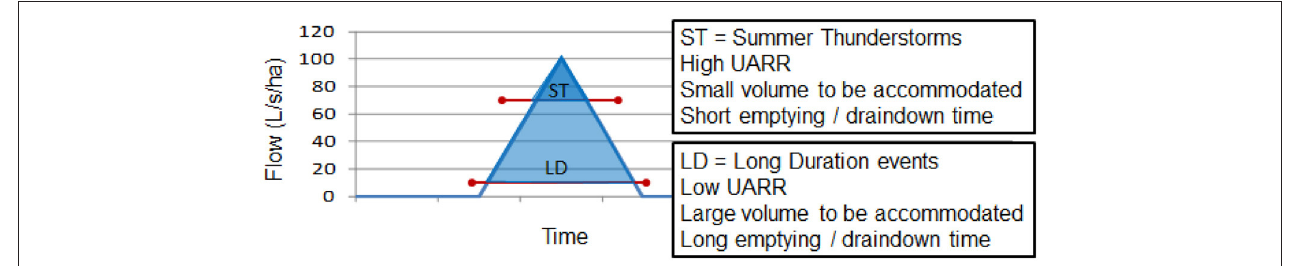
FIGURE 3 | Relationship between UARR and Type of Stormwater Management